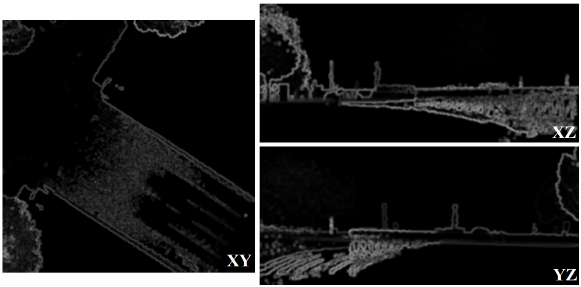
Figure 10. The three images produced from the point cloud set of Figure 1a illustrating gradient of depth values.